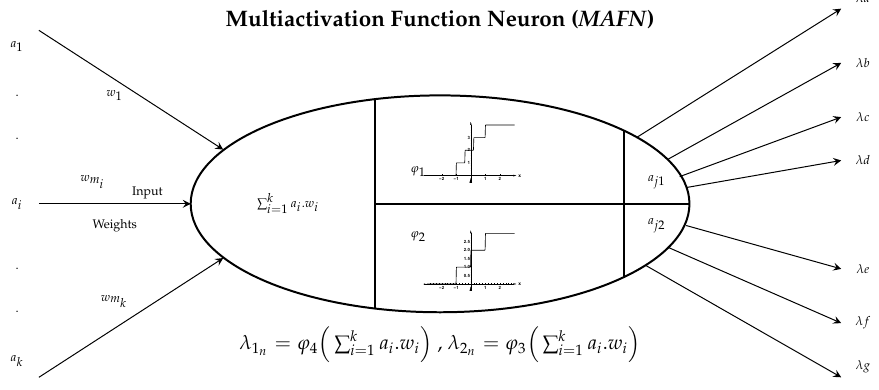
Figure 6. The structure of the MAFN where ϕ 1